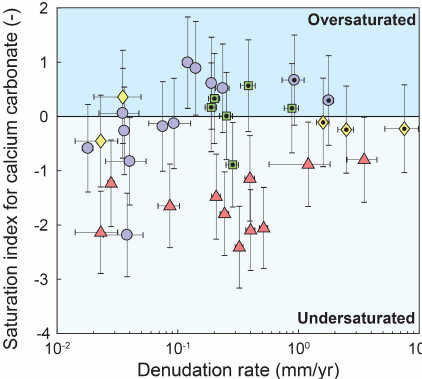
Figure A1. Saturation index of samples with respect to calcium carbonate. Catchments underlain by different lithologies are dis- tinguished by symbols and color. Data points with a black dot are metamorphosed to greenschist facies or higher.